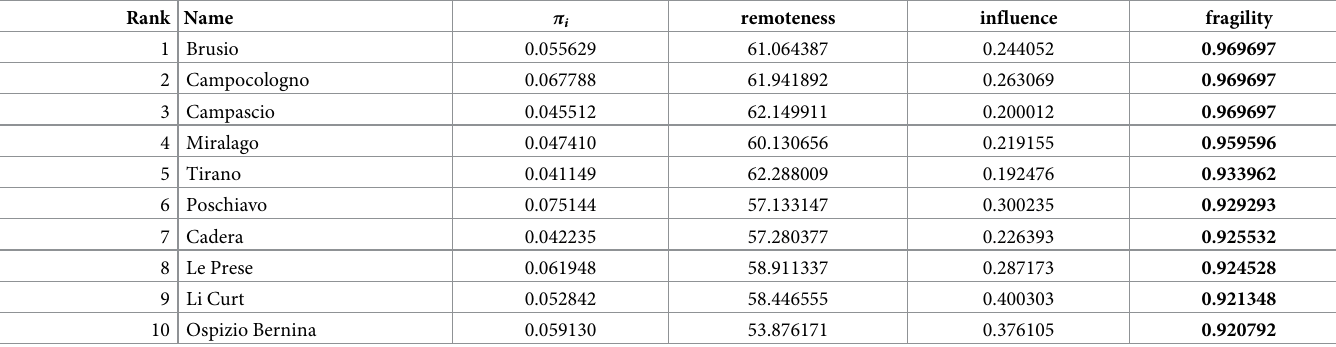
Table 3. Top ten most fragile stations, 1 month